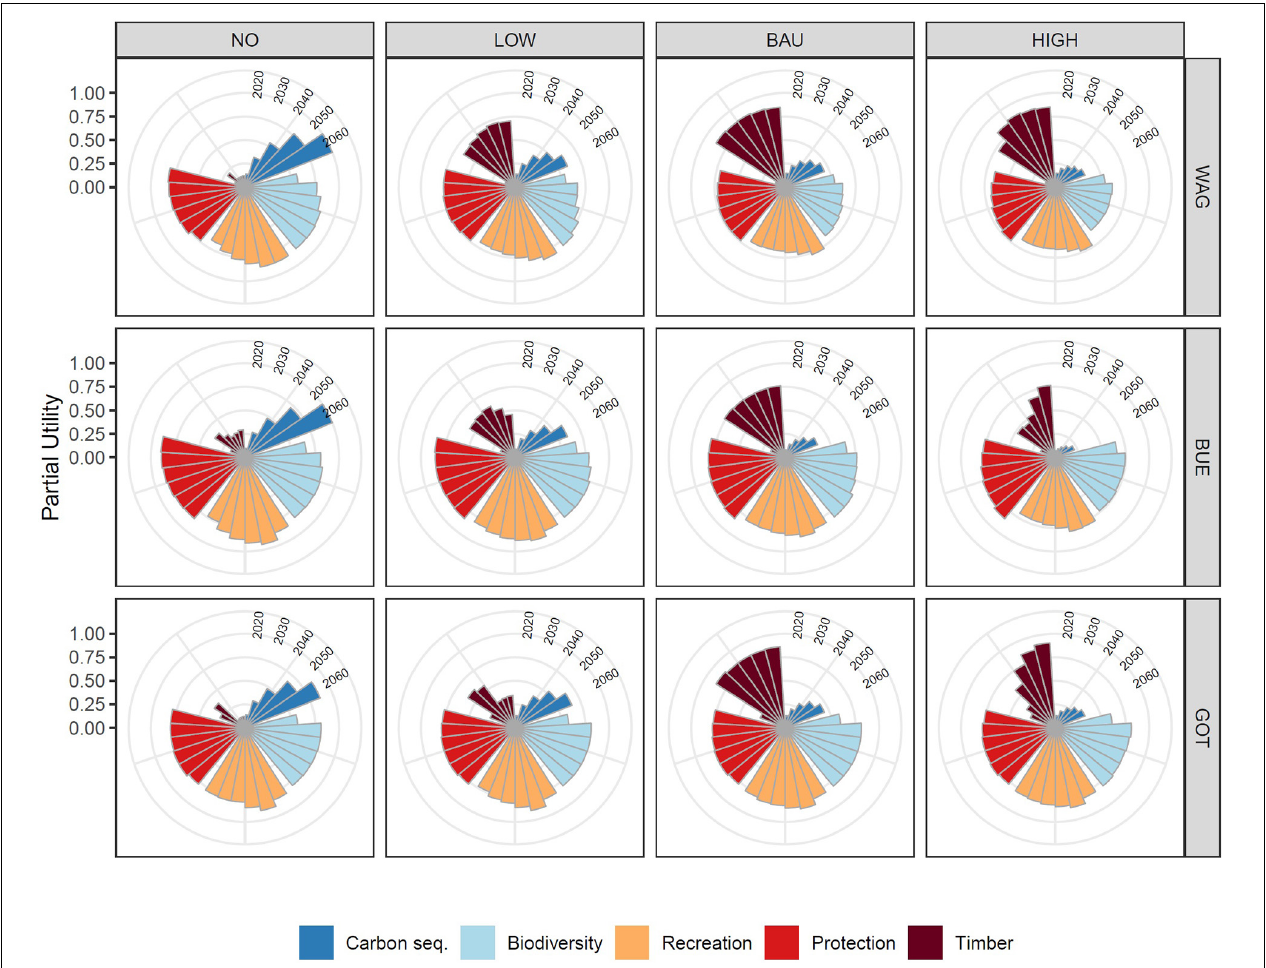
FIGURE 3 | Partial utility of biodiversity and ecosystem service (BES) indicators for four alternative management strategies (No management: ‘NO’; Low intensity: ‘LOW’; business as usual: ‘BAU’; High intensity: ‘HIGH’) at the three case study enterprises (WAG, BUE, GOT) under present climate conditions. Bars display temporal development and colors indicate different BES. Partial utility is scaled between 0 (lowest utility) to 1 (highest utility) for comparability. Note, that the absence of bars indicates a very low partial